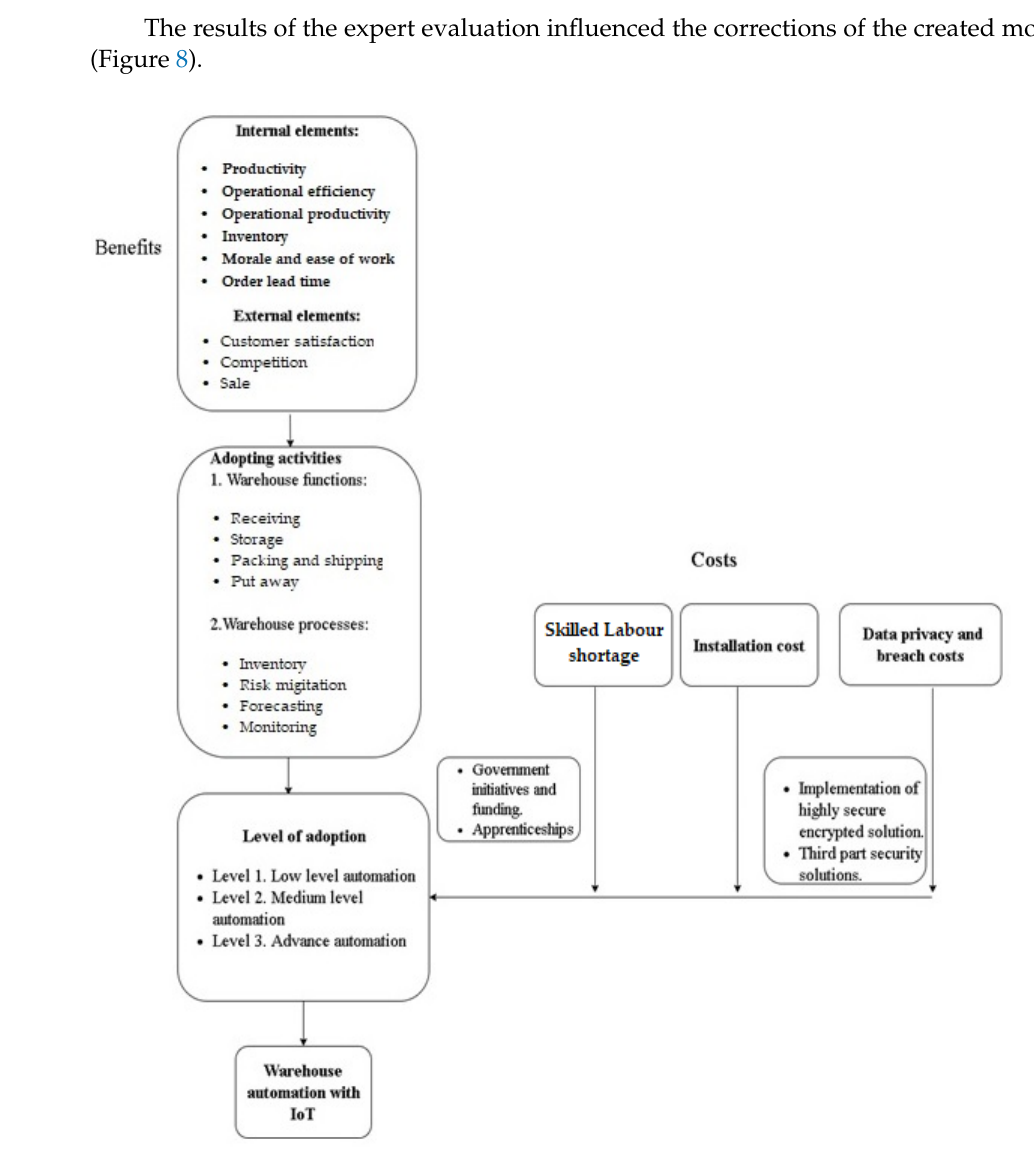
Figure 8. An improved conceptual model for applying Internet of Things tools in warehouse com- panies.